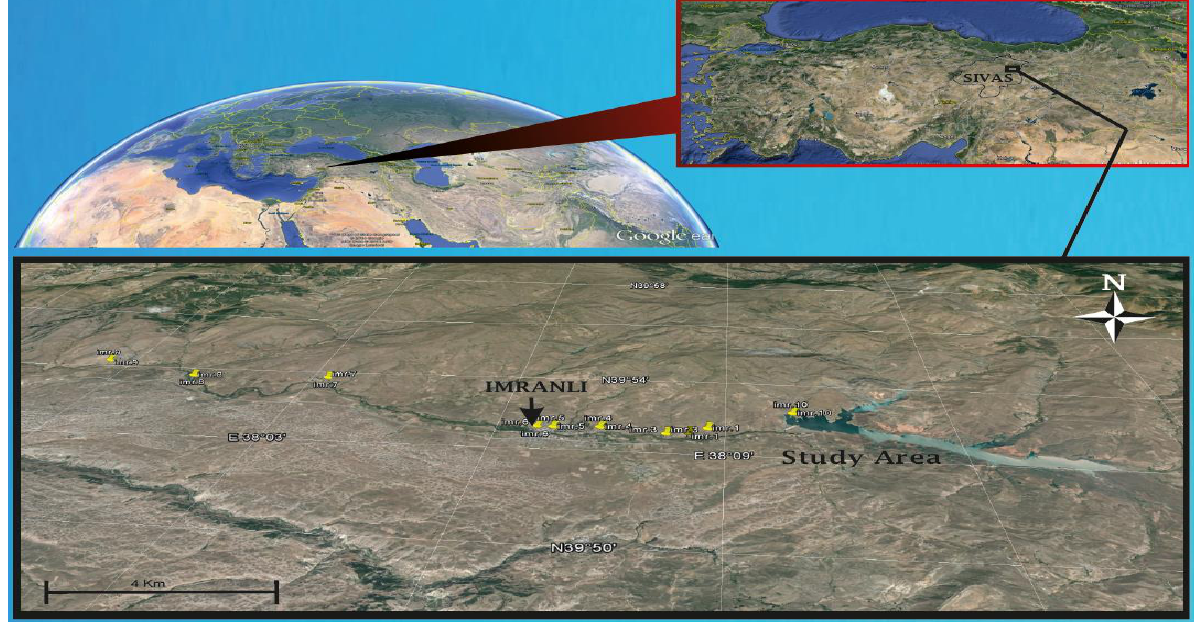
Figure 1. Study area (Yellow markers indicate locations where the water samples are taken)